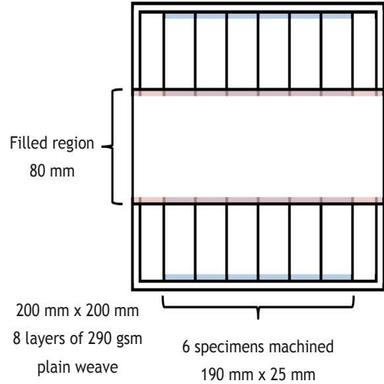
Schematic of 8-ply composite laminate showing specimens and region with microcapsules.